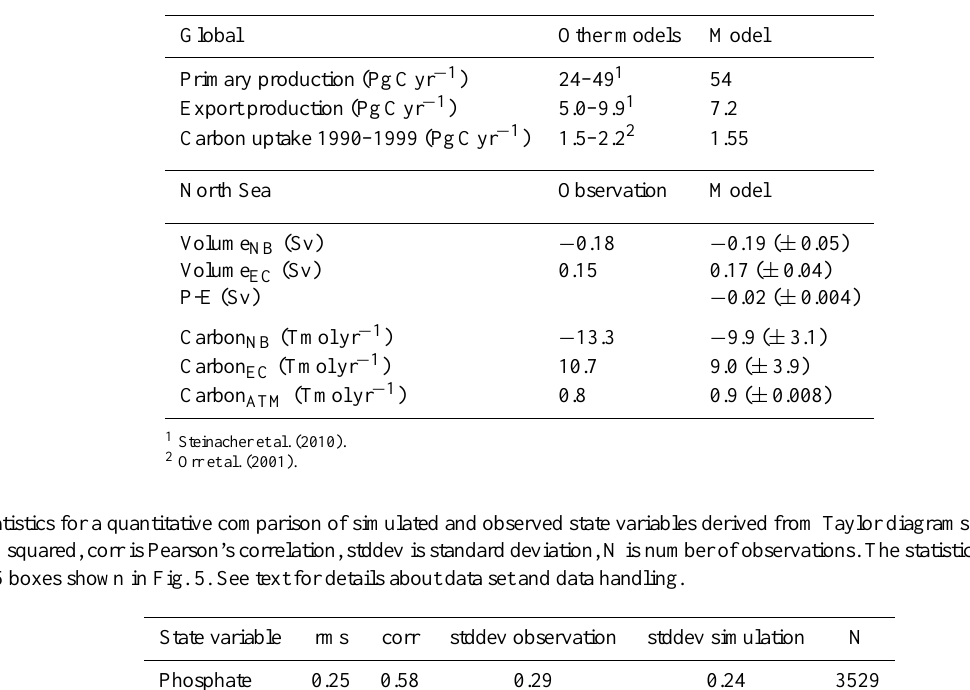
Table 3. Modelled global and regional mass fluxes averaged for the last decade of the 20th century. Mass fluxes for the North Sea refer to Thomas et al. (2005). NB is northern boundary, EC is English Channel, ATM is atmosphere, P–E is precipitation–evaporation.